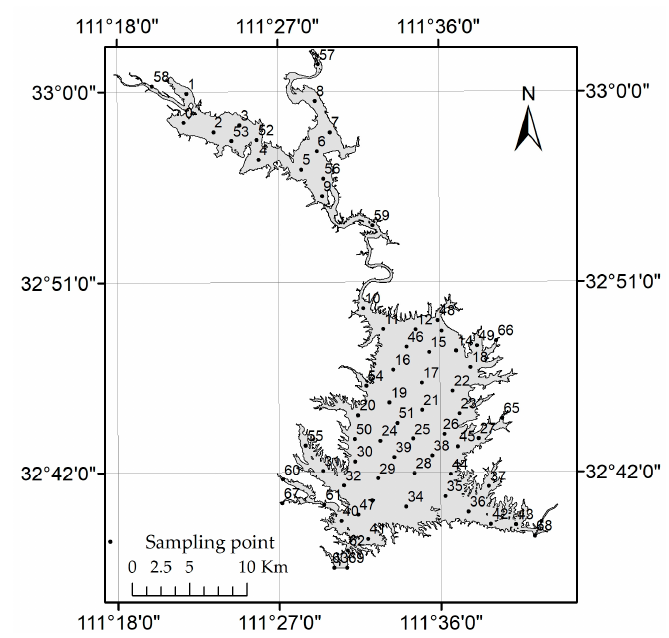
Figure 2. Distribution of the sample sites for water quality monitoring.